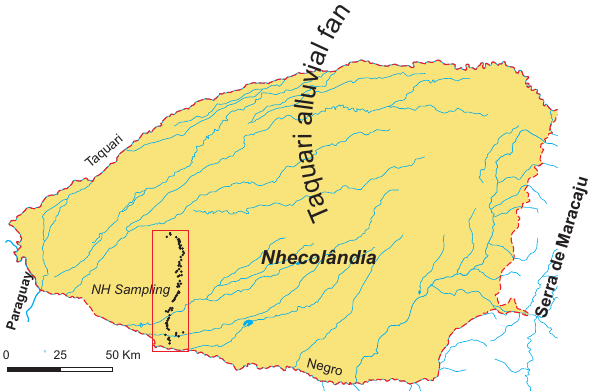
Fig. 4: Relationship between the electrical conductivities in dry season 2008 (sampling DS) and wet season 2010 (sampling WS). Fig. 4. Relationship between the conductivities in dry season 2008 (sampling DS) and wet season 2010 (sampling